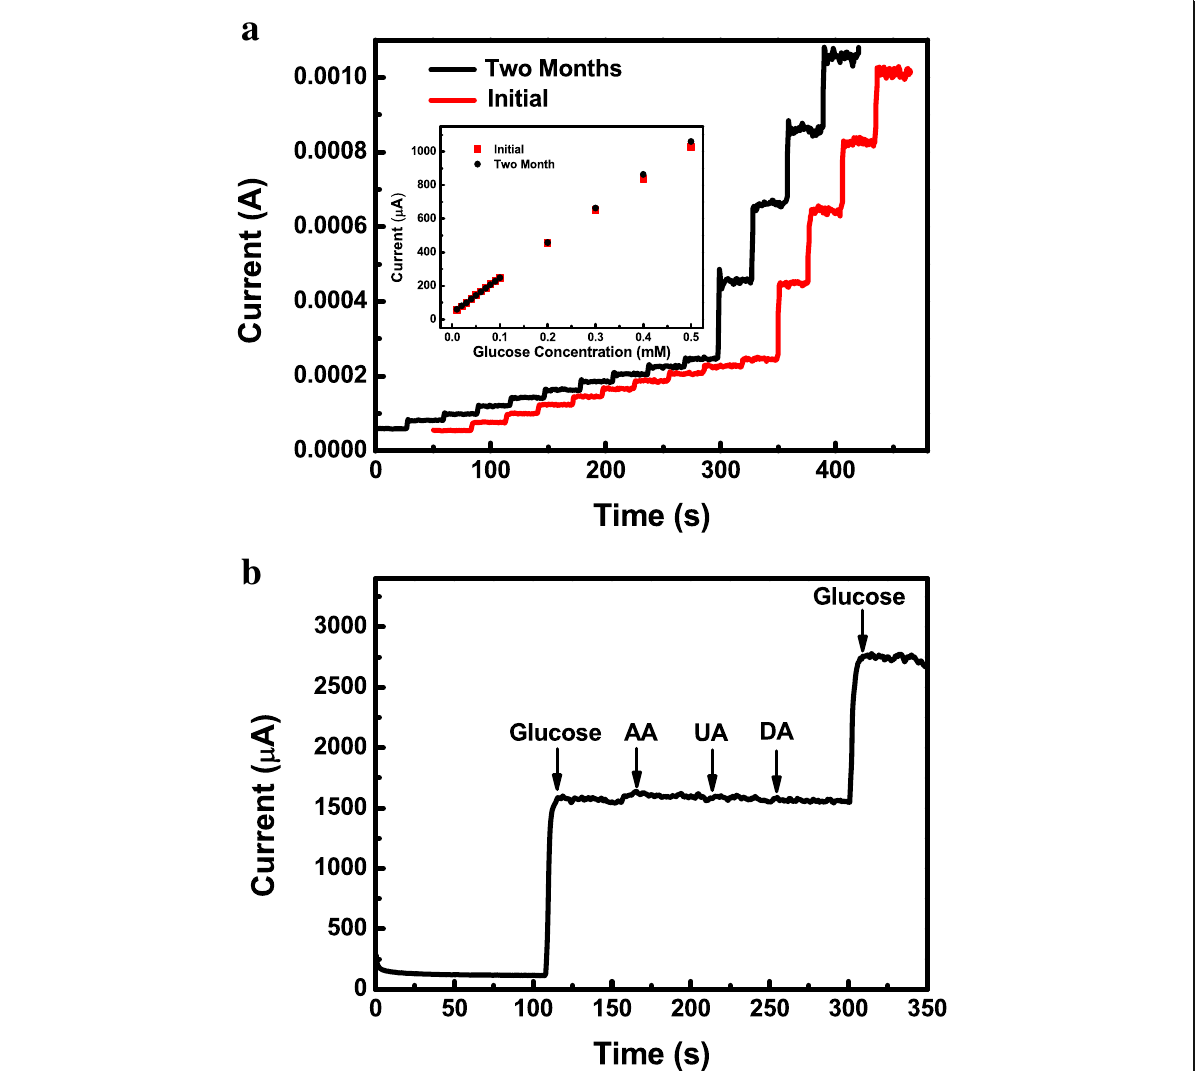
Fig. 6 The stability and selectivity of amorphous electrode for electrochemical sensors. a The current response to glucose with the successive step addition in 20 mL stirred electrolyte of 0.5 M NaOH over 2 months. b The amperometric current-time (i-t) curve of the glucose oxidation with other carbohydrates on the Co-Ni hydroxide electrode acquired in 20 mL stirred electrolyte of 0.5 M NaOH with the successive step addition of 1 mM glucose and 0.1 mM common